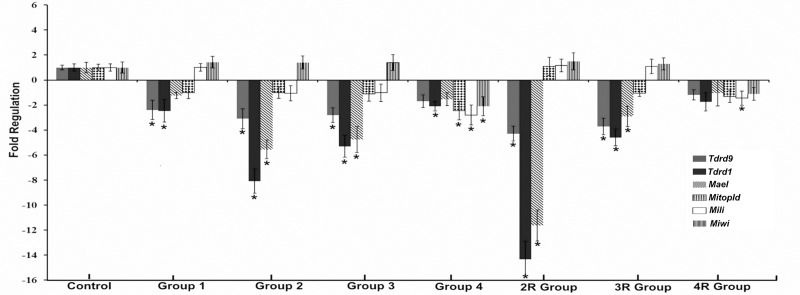
Effects of ovarian stimulation on Tdrd9, Tdrd1, Mael, Mitopld, Mili, and Miwi mRNA levels in ovarian tissue of the study groups.Fold-Regulation (FR) represents fold-change results in a biologically meaningful way. Fold-change values greater than one indicates a positive- or an up-regulation, and the FR is equal to the fold-change. Fold-change values less than one indicate a negative or down-regulation, and the FR is the negative inverse of the fold-change. *p<0.05.